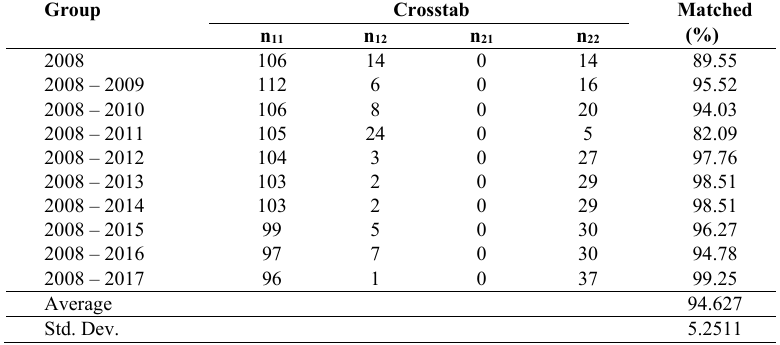
TABLE 12 P REDICTIONS A CCURACY FOR R EGULAR A DMISSION S TUDENTS Group Crosstab Matched